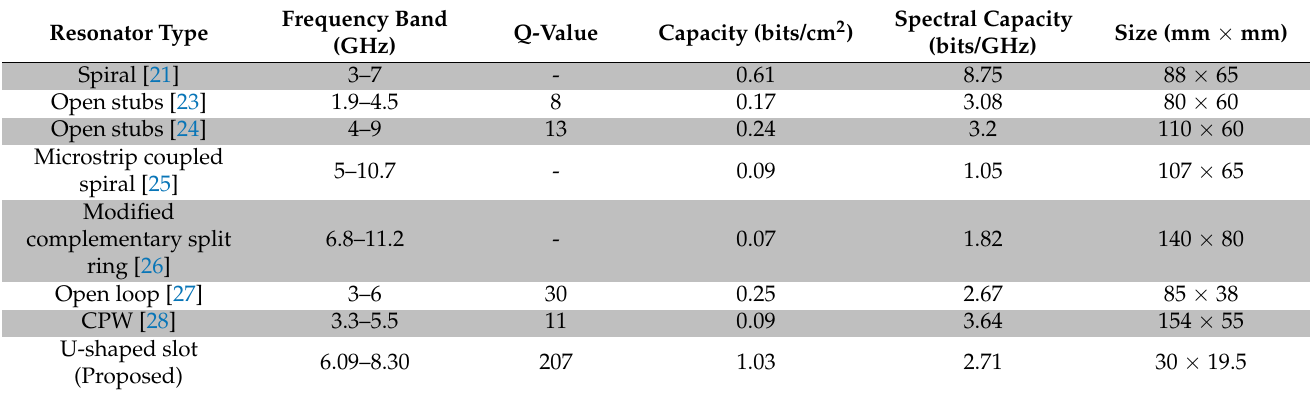
Table 2. Comparison of different types of retransmitted chipless